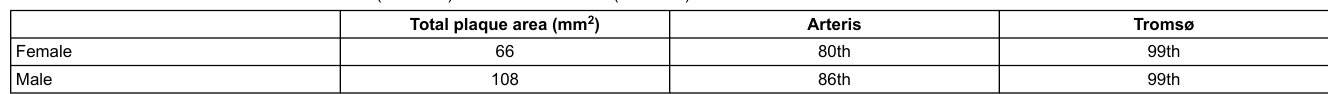
Table S1: Percentile value of VA70 in the Arteris (n = 5383) and Tromsø cohorts (n =